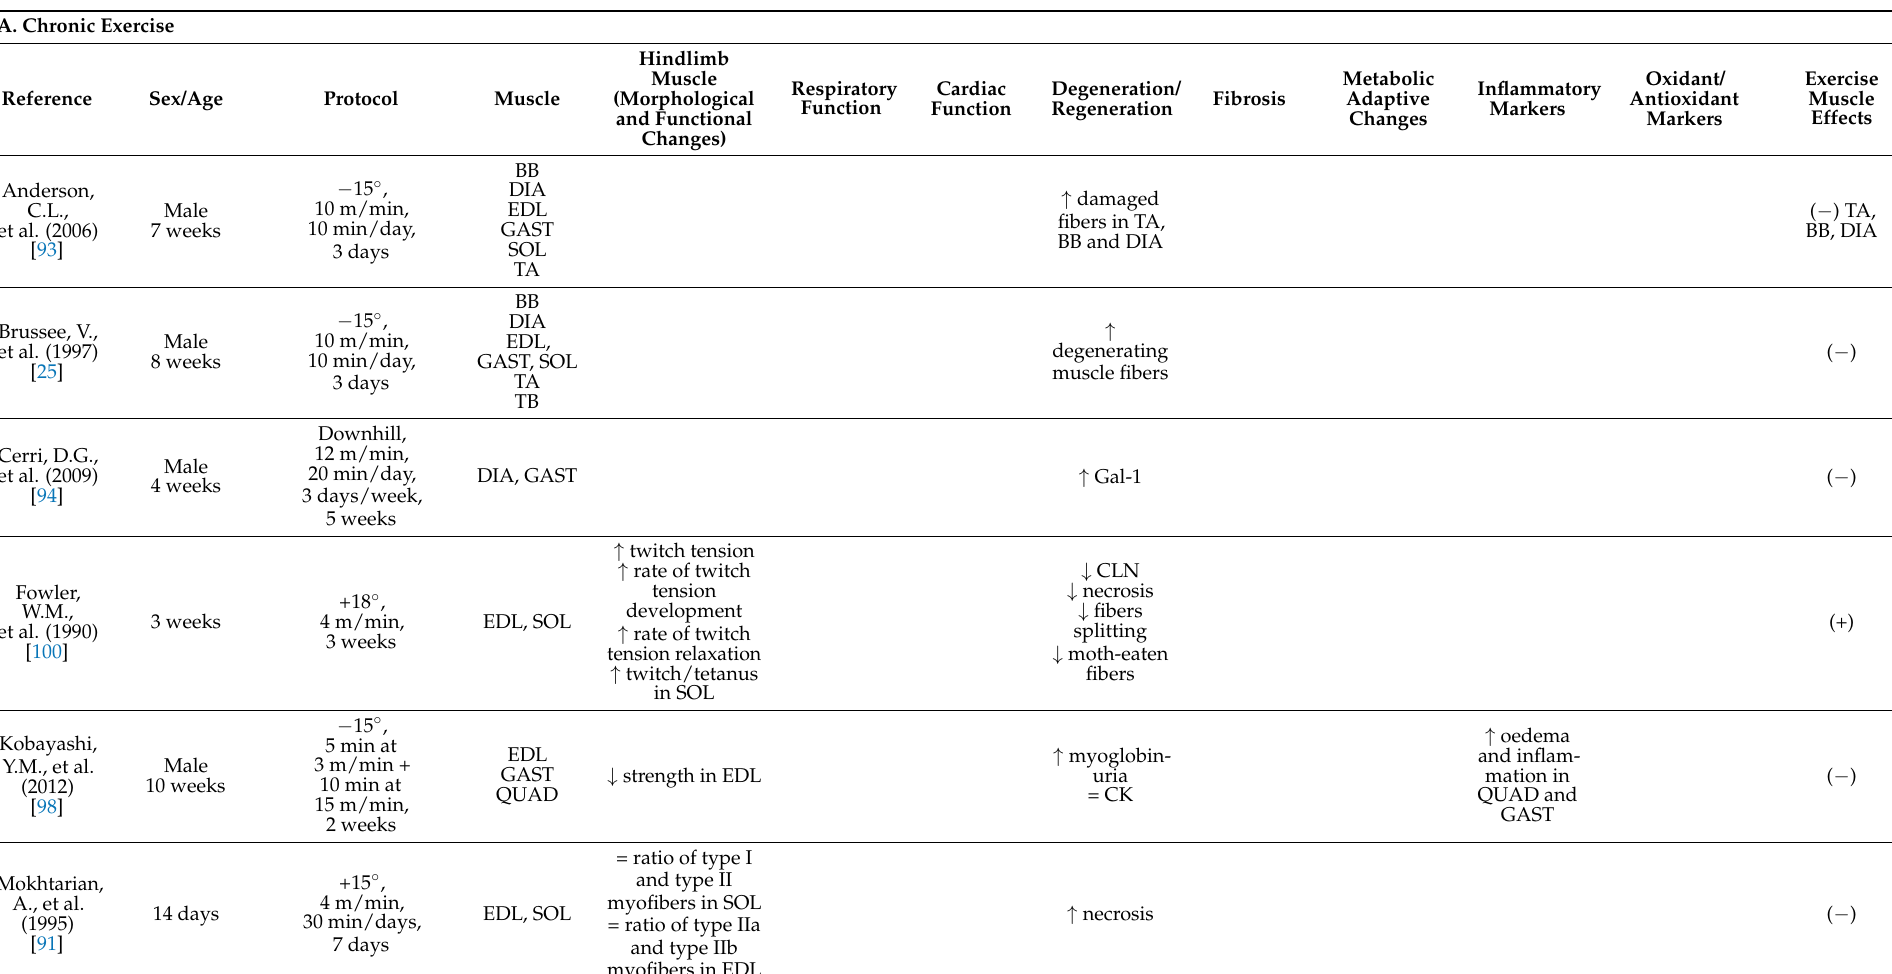
Table A2. Effects of downhill and uphill running on mdx mouse